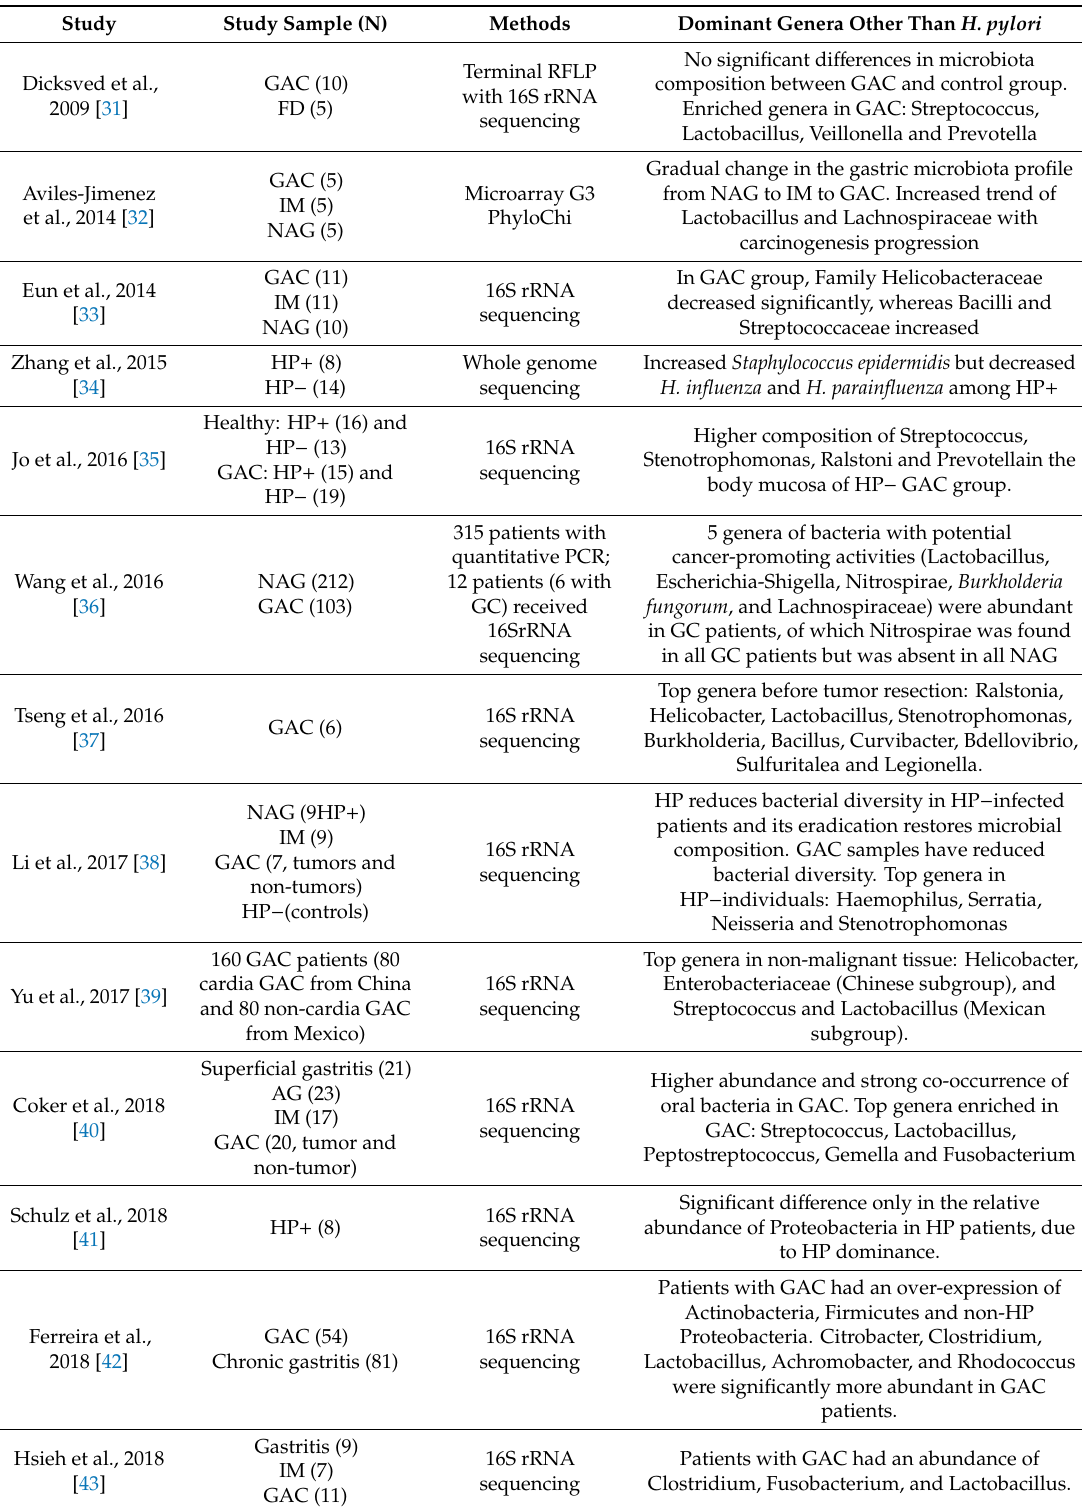
Table 1. Studies implicating other non- H. pylori bacteria in gastric cancer